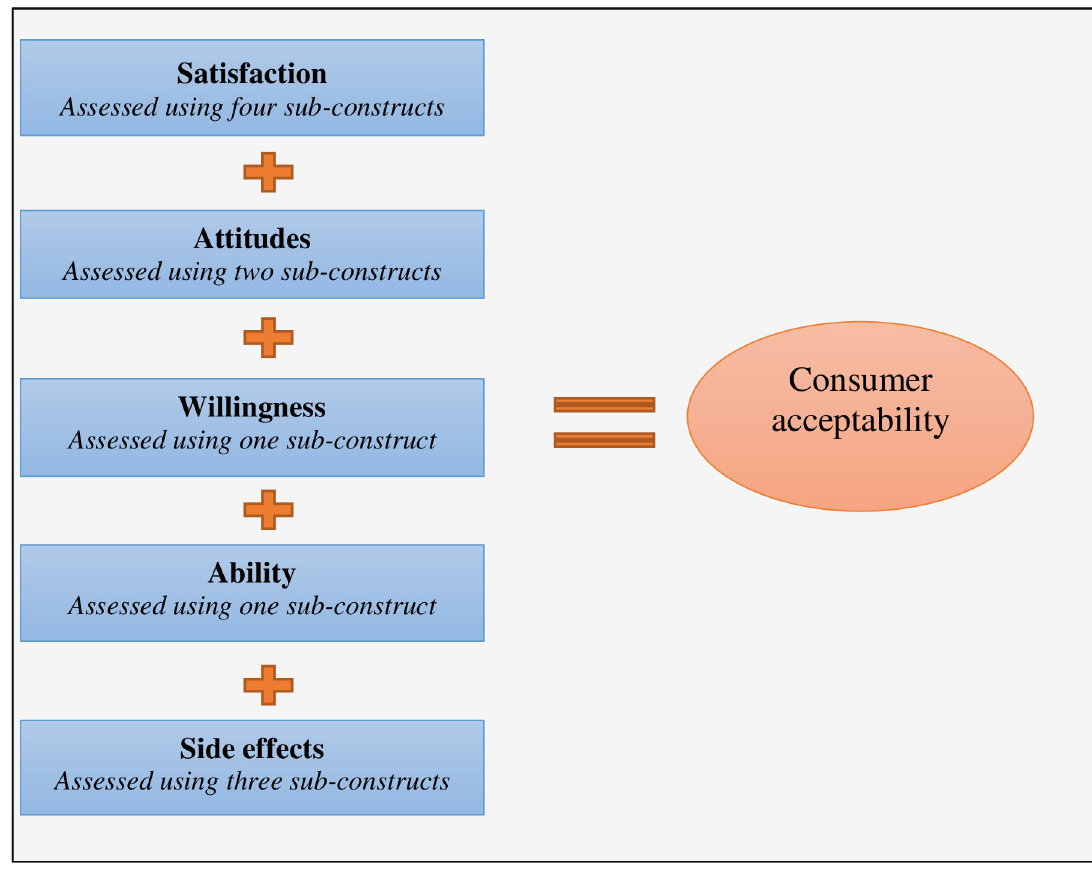
Fig 3. Consumer acceptability